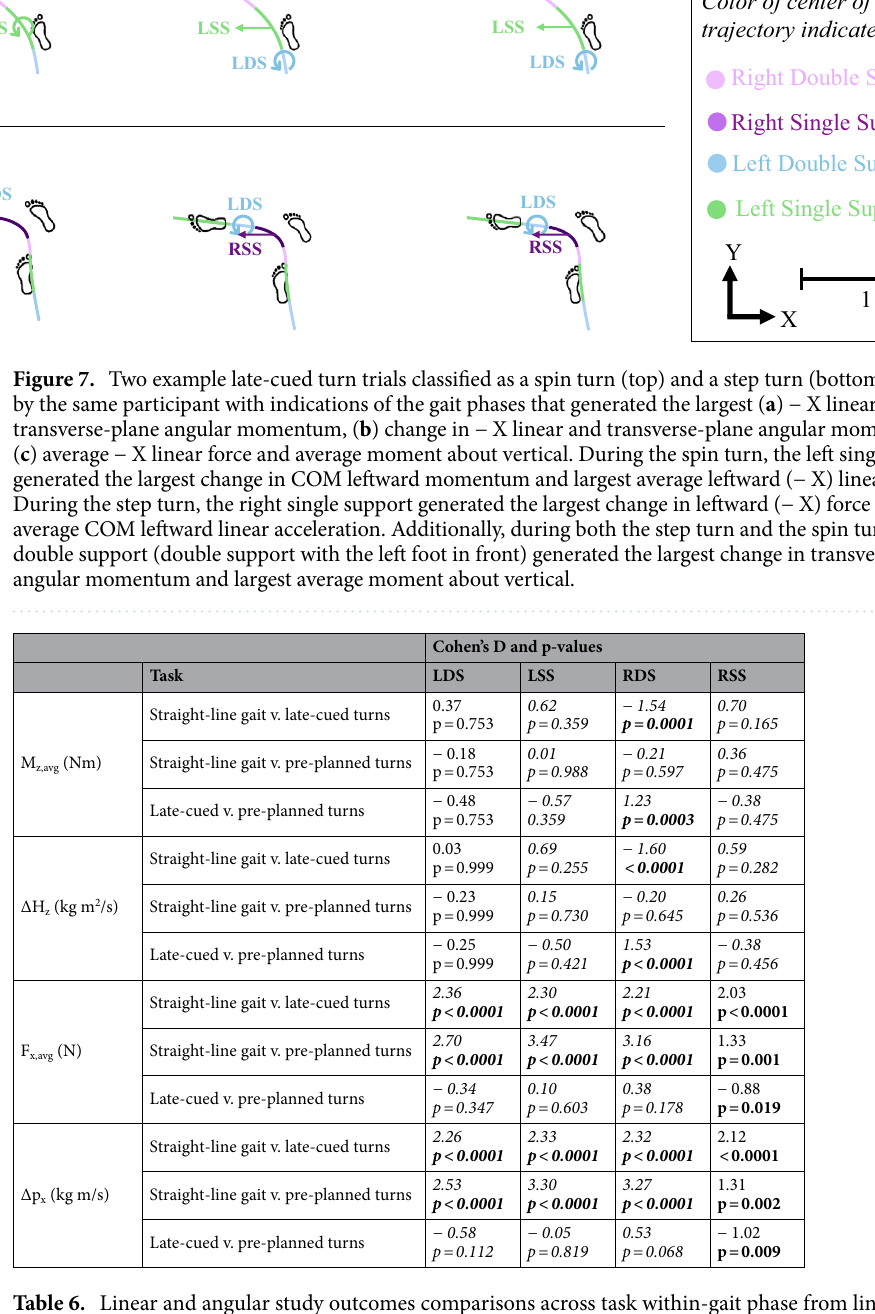
Table 6. Linear and angular study outcomes comparisons across task within-gait phase from linear mixed models. Acronyms: Left Double Support (LDS) Left Single Support (LSS), Right Double Support (RDS), Right Single Support (RSS), change in transverse-plane angular momentum (∆H z ) average transverse-plane moment (M z,avg ), linear momentum (∆p x ), and global X-axis average force (F x,avg ). Positive values for H z and M z rotate the body leftwards, in the direction of the turn. Negative values for p x and F x are leftward in the direction of the turn. Bolded p-values indicate statistically significant differences. Italic text indicates comparisons that were not related to the gait phase that was pertinent to the linear or angular hypotheses. Note, estimated marginal means and confidence intervals for these study outcomes have already been provided in Tables 1 and